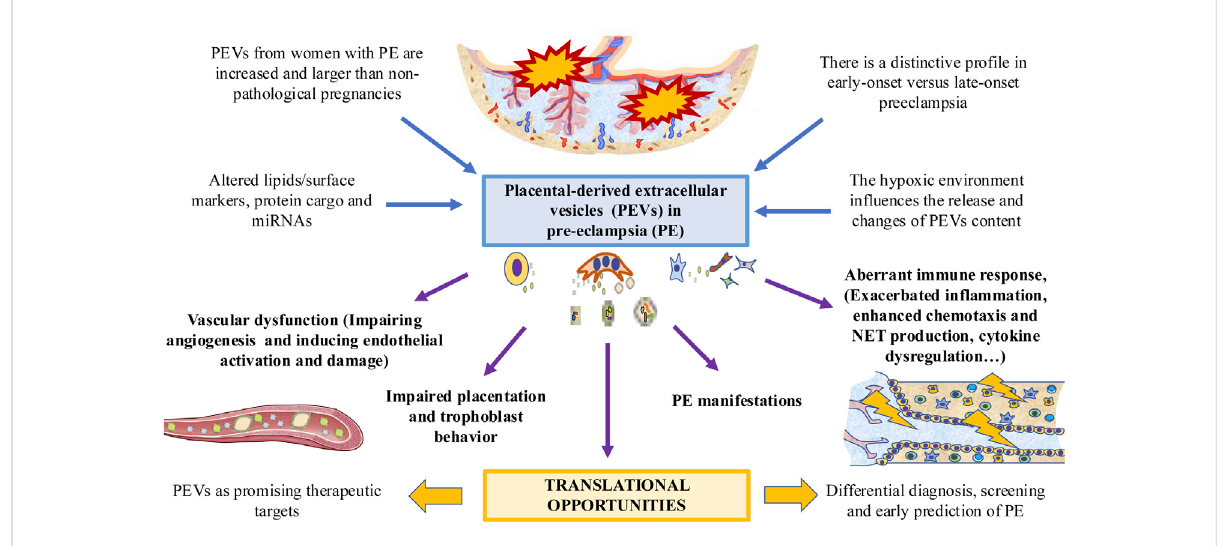
FIGURE 2 The role of PEVs in PE. PEVs are increased in women affected with this condition, with multiple changes in their surface and cargo. These changes are different in early versus late-onset PE. A possible modulator of PEVs is the low oxygen tension and hypoxic environment. PEVs released by the placenta participates in the PE-associated vascular dysfunction, impairing placentation and trophoblast behavior, dysregulating the immune system and leading to different PE manifestations. This can arise potential translational opportunities for